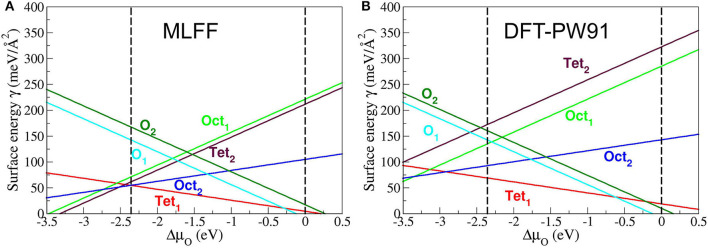
Stability diagrams for the six (ideal) bulk terminations of Fe3O4(111). (A) Diagram obtained using FFslab (see text). (B) Diagram obtained using the PW91 functional, which is supposed to perform similarly compared with PBE. (B) is redrawn with permission from Kiejna et al. (2012). Copyright (2020) by the American Physical Society.